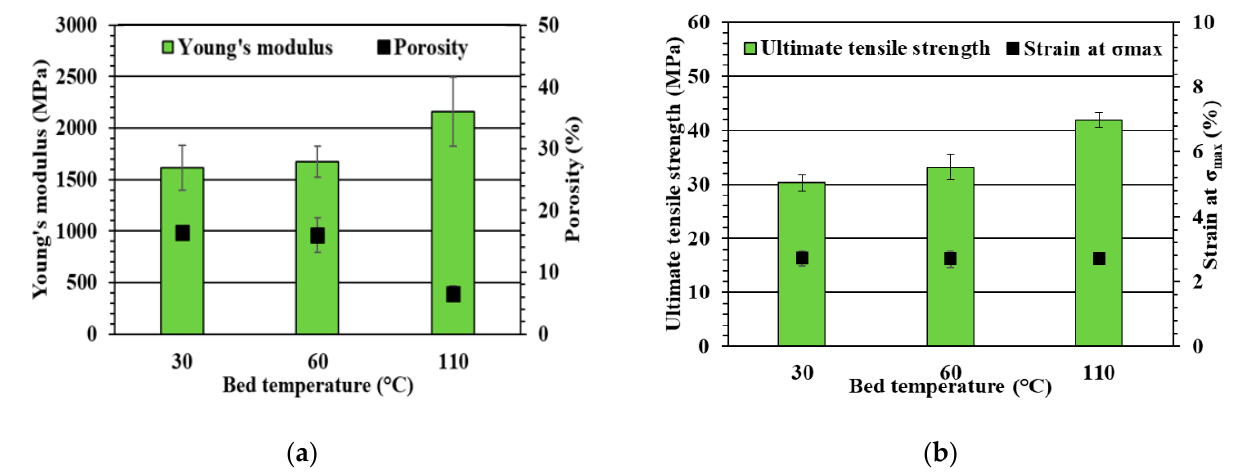
Figure 9. Influence of bed temperature (30 °C, 60 °C, and 110 °C) on ( a ) Young’s modulus and porosity and ( b ) ultimate tensile strength and the strain at the ultimate tensile strength.